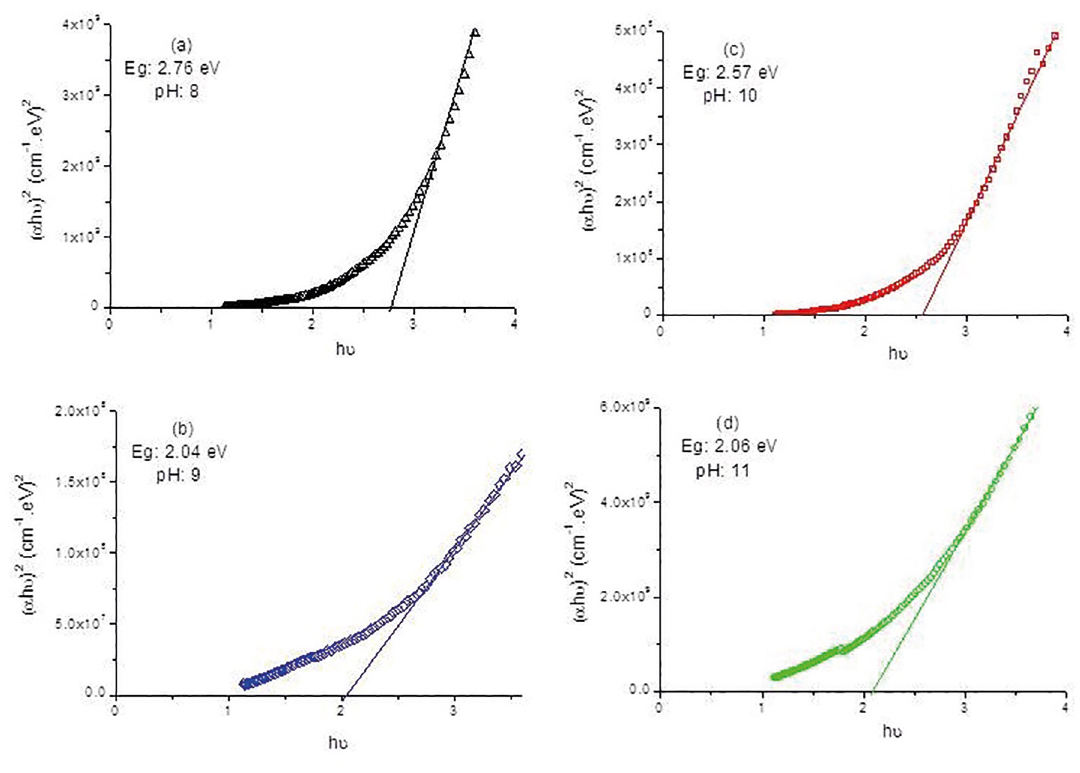
Figure 3. Plot of (αhυ) 2 vs. hυ for MnSeO